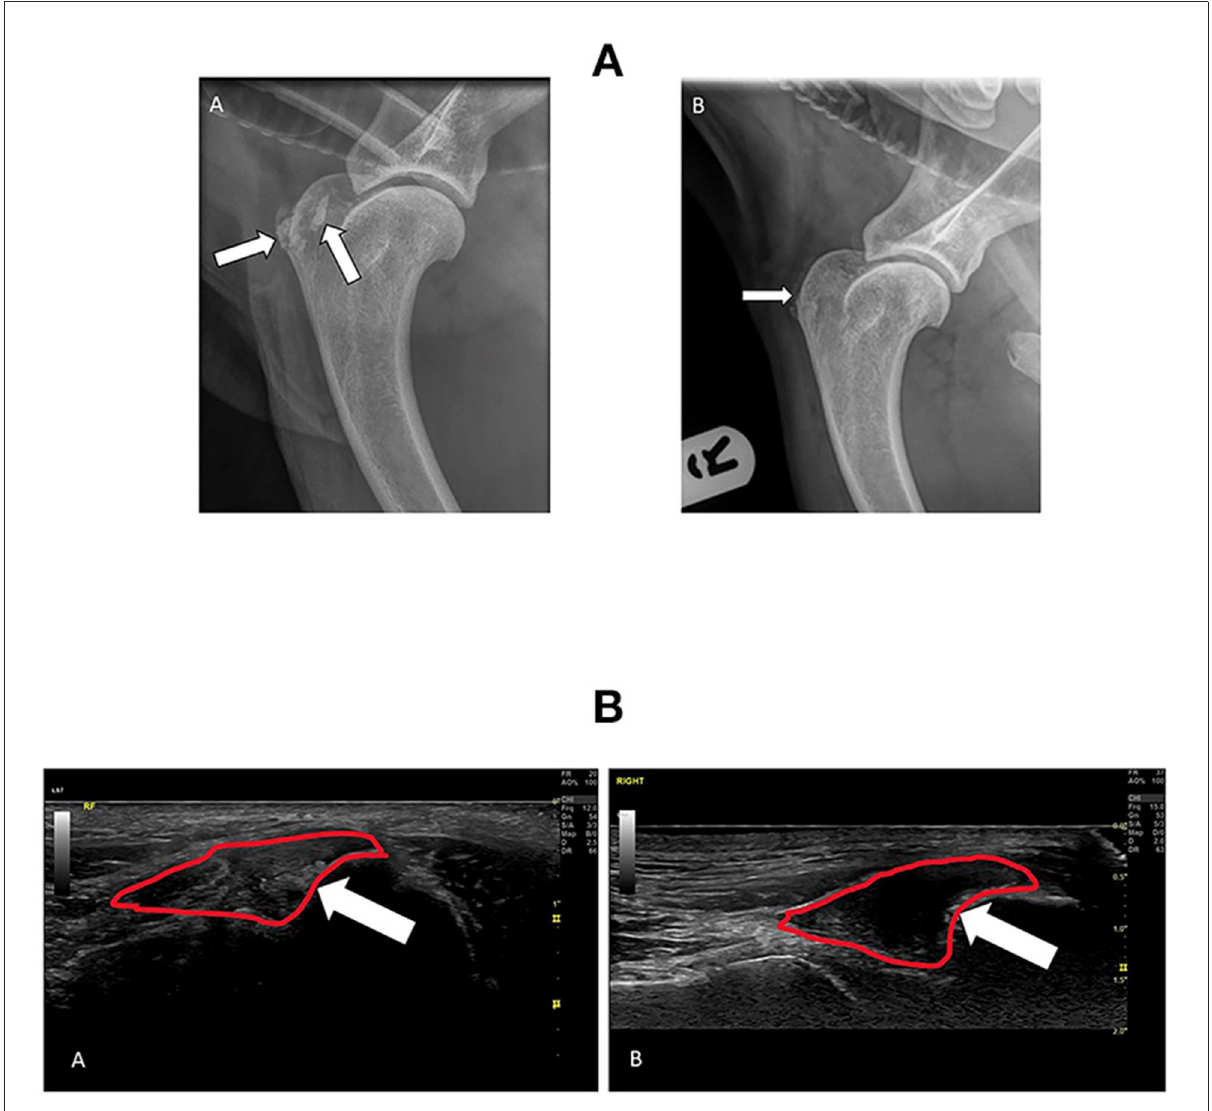
FIGURE4 (A) Radiographs of the right shoulder from a 7-year-old male neutered Labrador with concurrent elbow dysplasia and OA showing extent of Supraspinatus (SS) tendon mineralization at the time of diagnosis (A) and 3 months following treatment with RM (B). The white arrows point